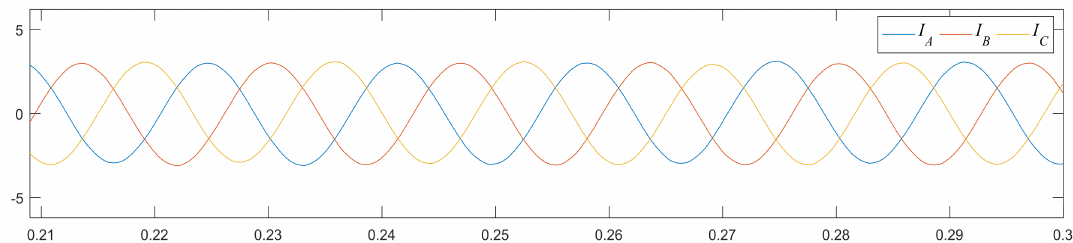
Figure 6. Three-phase output current for the proposed converter.